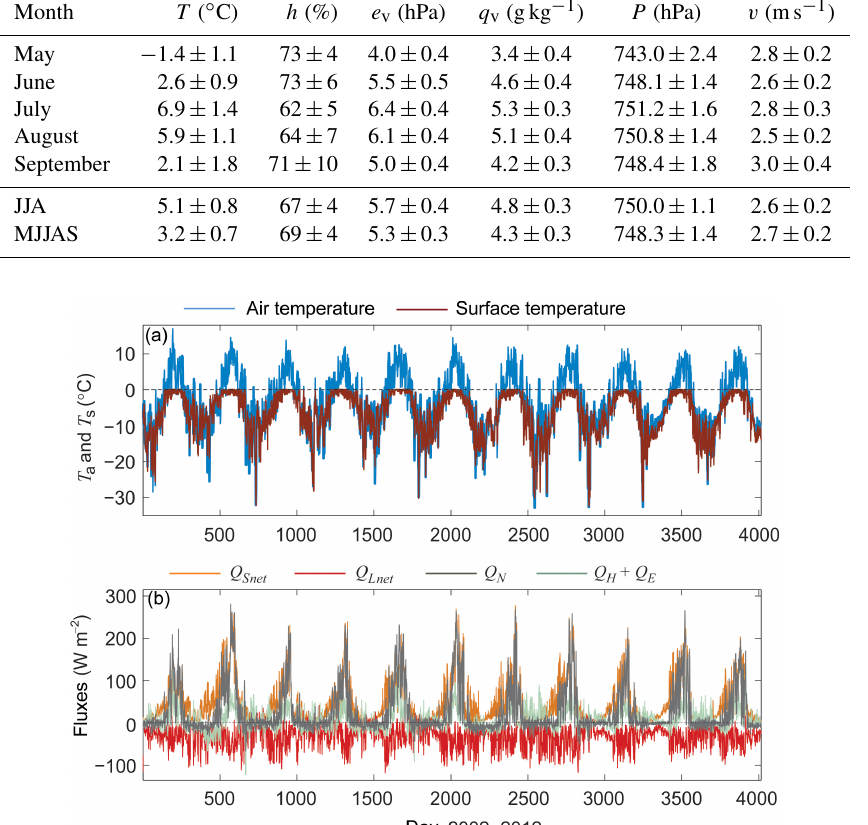
sider only the point energy balance at the glacier AWS